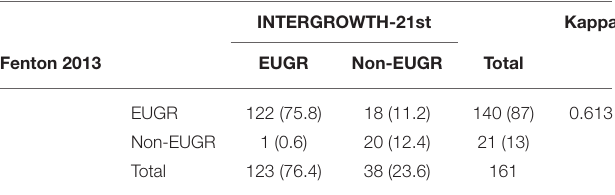
TABLE 4 | Static EUGR in weight ( < 10th percentile at hospital discharge) in < 1,000g.